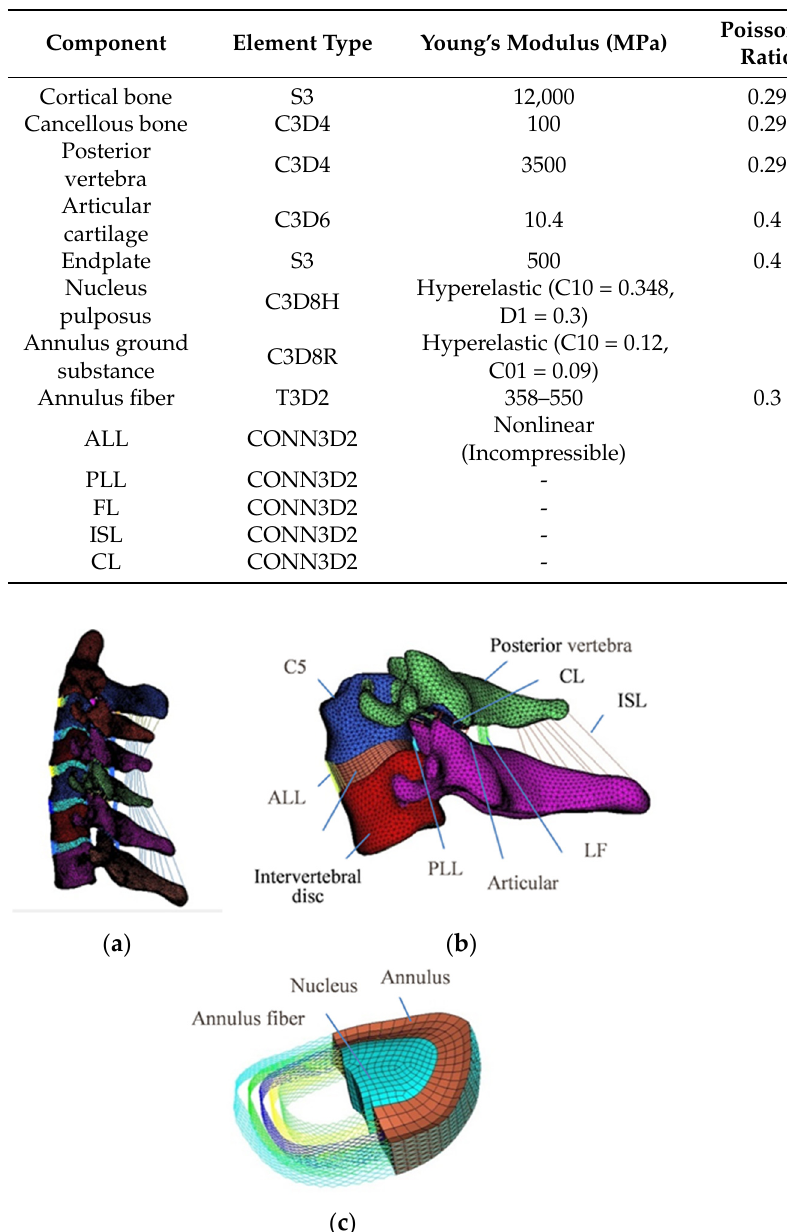
Table 1. Element types and mechanical properties of the FE model.